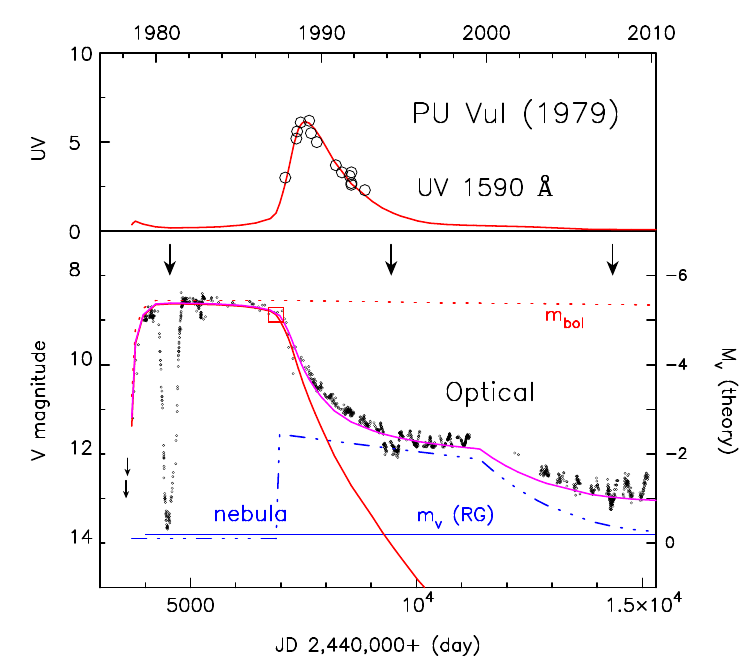
Fig. 7. A composite light curve model of PU Vul. The magenta solid line in the lower panel indicates a composite light curve of three components of emission from the WD photosphere (red thick solid line), RG mean luminosity (horizontal thin solid line at m v = 13 : 8), and nebula emission (dash-three-dotted line). The 0 : 6 M ⊙ WD model is depicted by the solid lines for UV 1590 ˚A band in units of 10 − 13 erg cm − 2 s − 1 ˚A − 1 (above: the same figure as in Figure 1d), for the V band (lower figure: the red thick solid line) and by the horizontal dotted curve for bolometric magnitude. Optical data are the same as in Kato et al. (2011). This trial V -band light curve gives a little bit smaller luminosity, so the curves are shifted upward by 0.26 mag. The downward arrows indicate the central time of